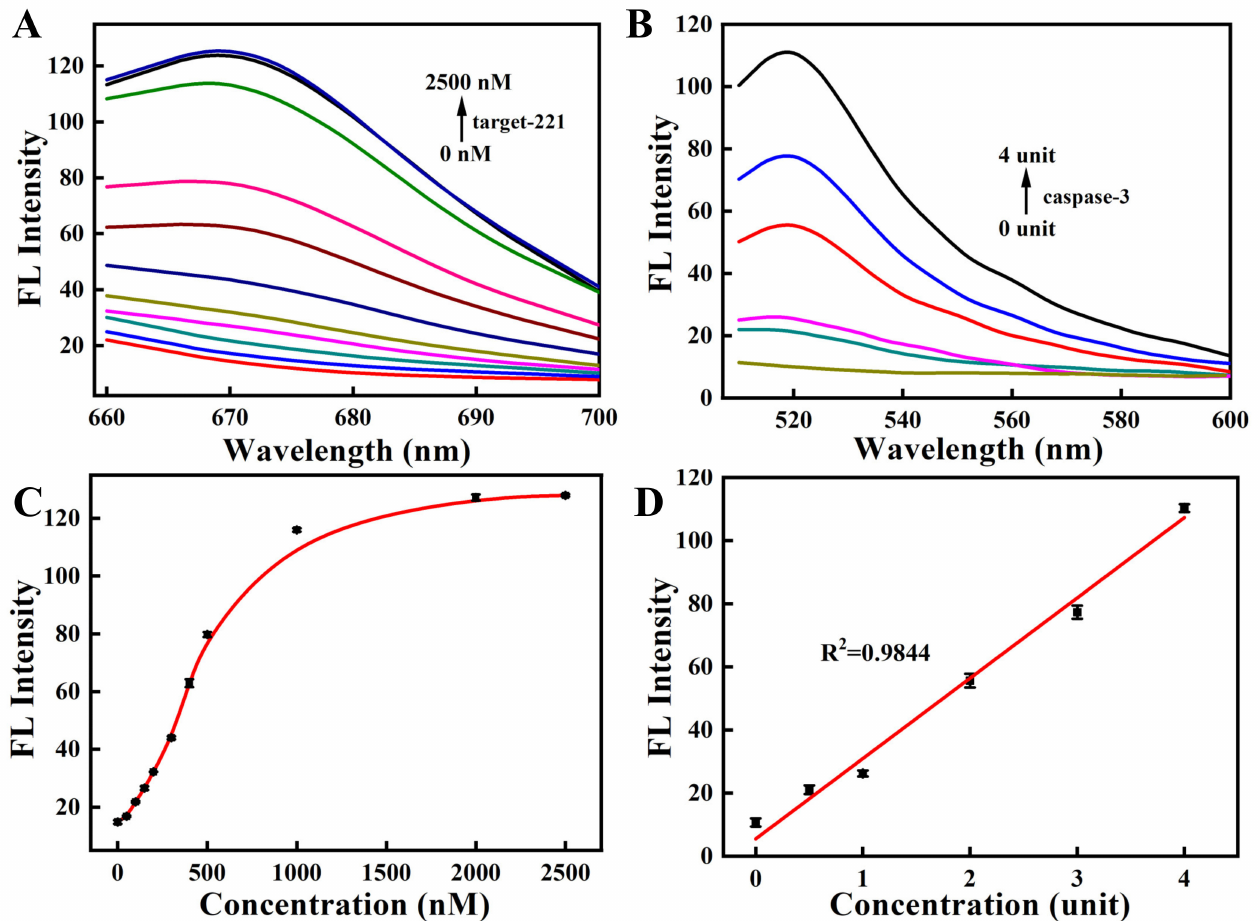
Figure 4. The fluorescence response spectra of the nanosensor with various concentrations of miRNA- 221 ( A ) and caspase-3 ( B ). (Cy5-labeled MB, targeting target-221, λ ex/ λ em = 648 nm/667 nm; FITC- labeled peptide, targeting caspase-3, λ ex/ λ em = 480 nm/520 nm.) The fluorescence recovery of the nanosensor in the presence of target-221 ( C ) and caspase-3 ( D